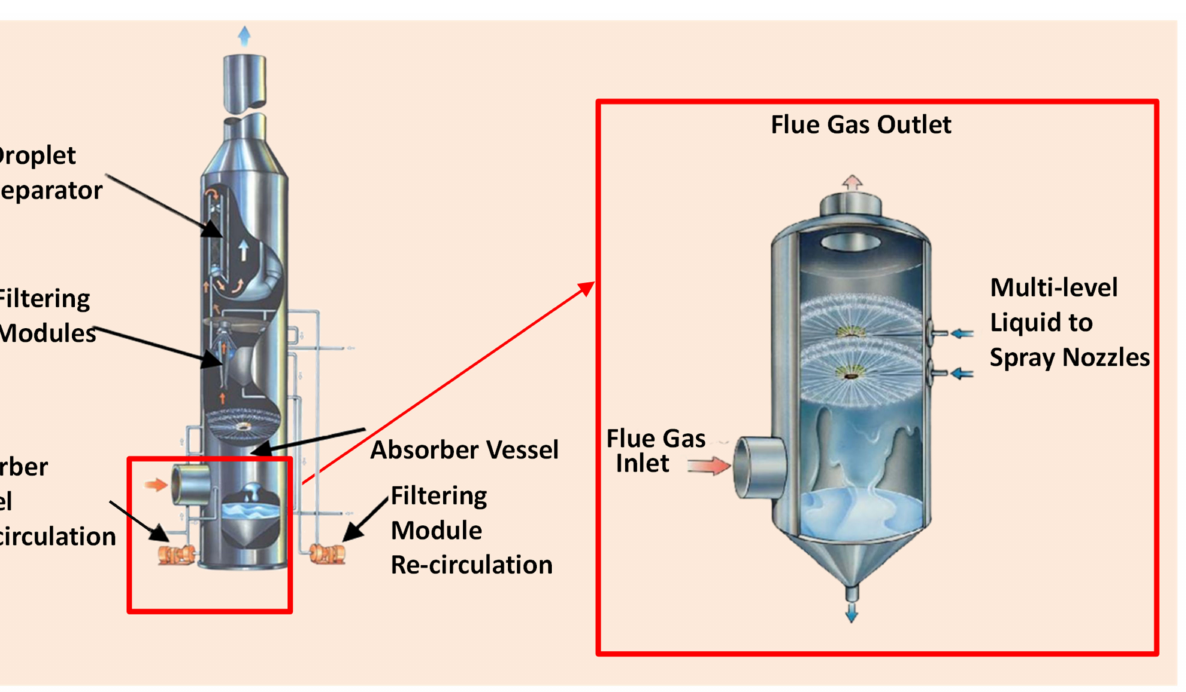
Figure 31. ( left ) Nonregenerative EDV wet scrubber apparatus; ( right ) spray tower. Adopted from Weaver